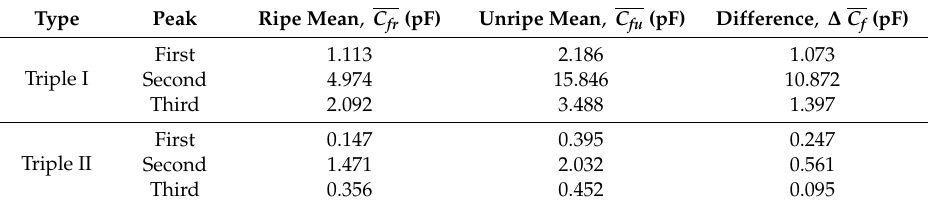
Table 6. Triple coil mean fruitlet capacitance for ripe and unripe, with the difference between them. Type